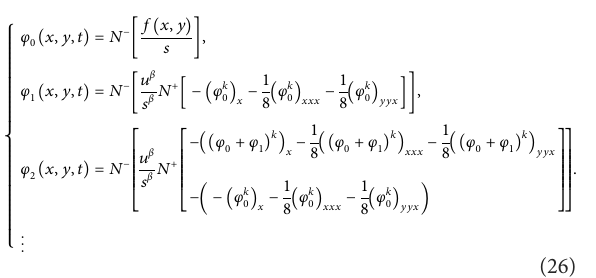
The n − terms approximate solution of Eqs. 18 and 19 by NTIM